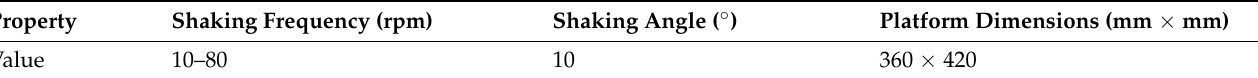
Table 1. Properties of the rocking shaker.